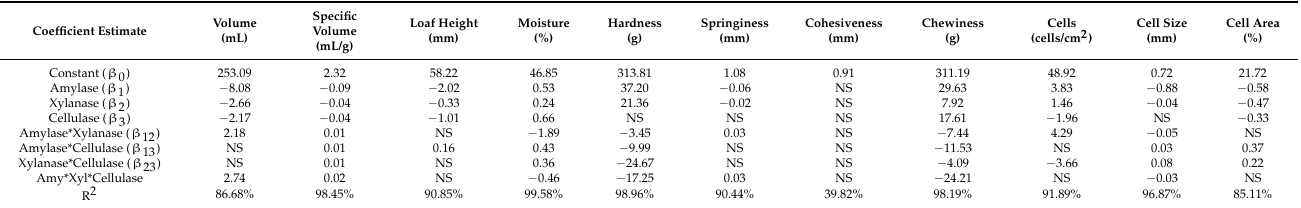
Table 2. Estimated regression coefficients of the factors of the physical properties of